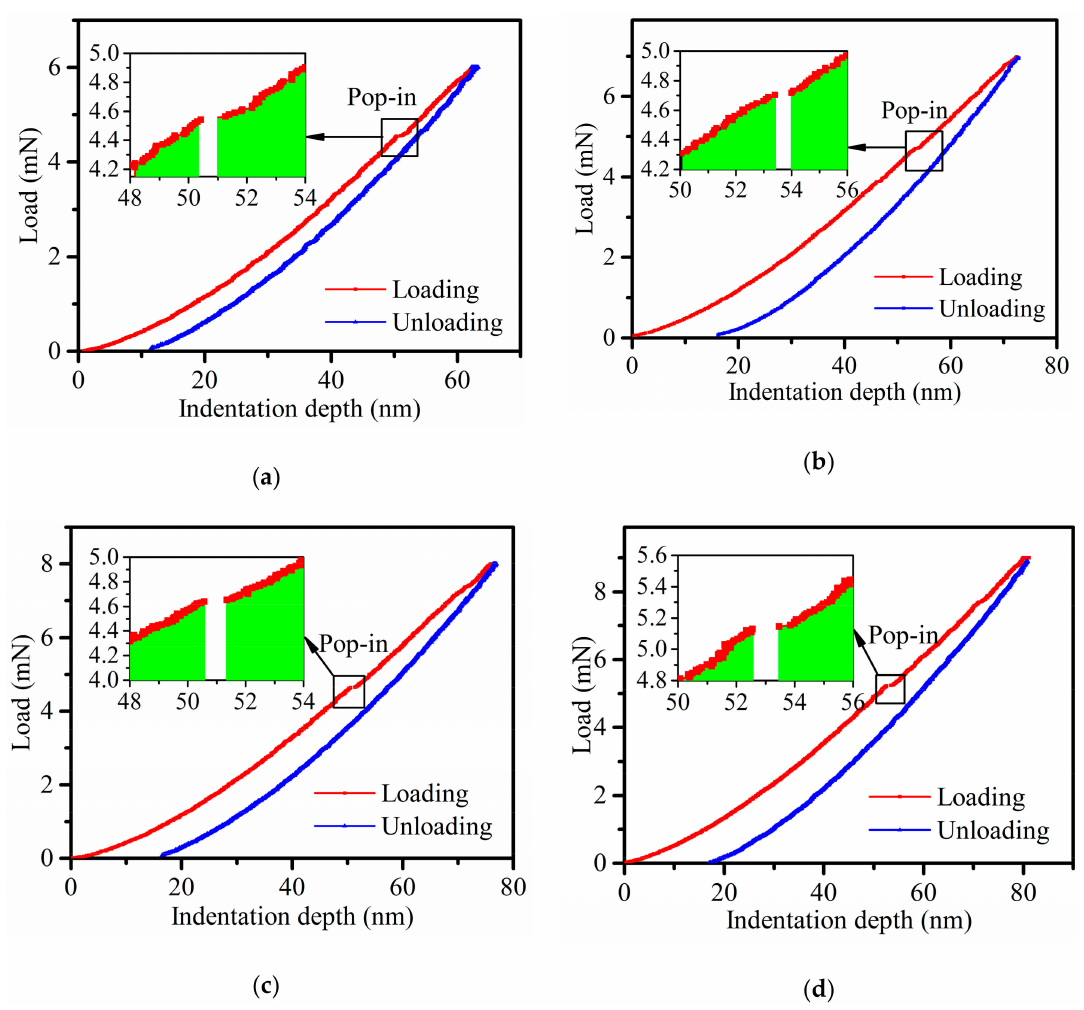
Figure 6. The load versus indentation depth curves for brittle deformation of indentations: ( a ) the maximum load of 6 mN, ( b ) the maximum load of 7 mN, ( c ) the maximum load of 8 mN, and ( d ) the maximum load of 9